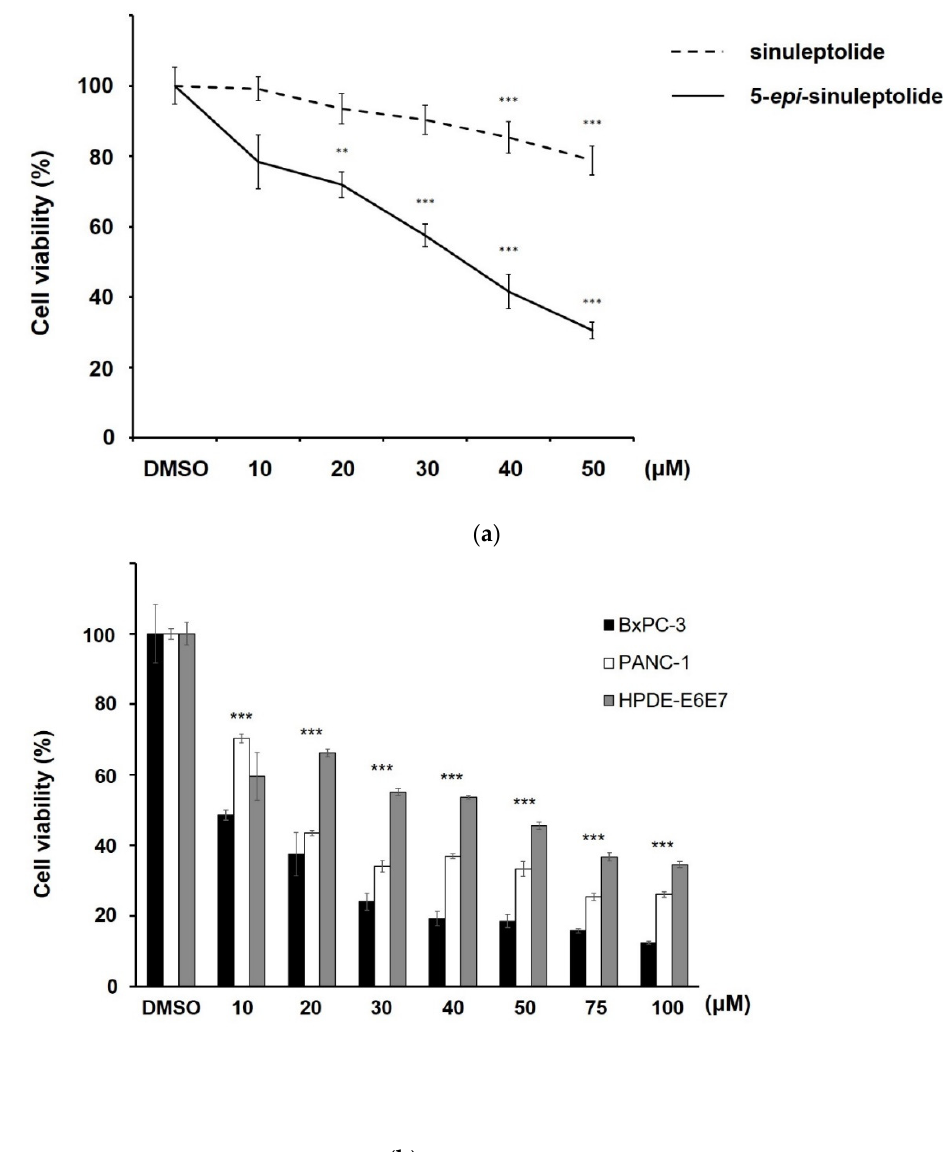
Figure 2. Selective cytotoxicity of 5- epi -sinuleptolide in pancreatic cancer cells. Cell viability was assessed by MTT assay after 24 h of treatment. Gemcitabine-sensitive BxPC-3 cells were incubated with different concentrations of sinuleptolide or 5- epi -sinuleptolide ( a ). The graph represents the mean of three experiments with the viability of DMSO-treated control normalized to 100% as the mean ± standard deviation. ** indicates p < 0.01, and *** p < 0.001 of sinuleptolide or 5- epi -sinuleptolide-treated BxPC-3 cells compared to DMSO-treated control. BxPC-3 with PANC-1 (gemcitabine-resistant), and HPDE-E6E7 (immortalized pancreatic cells) were exposed to 5- epi -sinuleptolide at indicated concentrations ( b ). The graph represents the mean of three experiments with the viability of DMSO-treated control normalized to 100% as the mean ± standard deviation. *** represents the p -value < 0.001 of 5- epi -sinuleptolide-treated BxPC-3, PANC-1, and HPDE-E6E7 cells compared to DMSO-treated control.